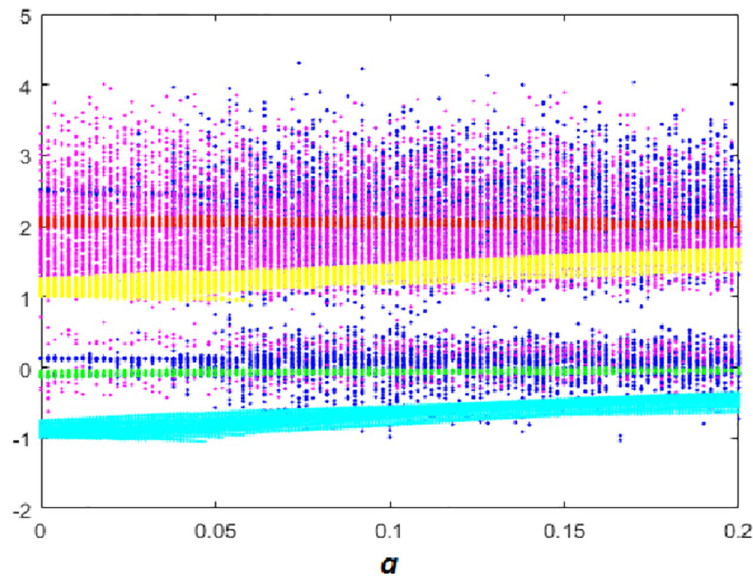
Fig 11. Bifurcation diagram of system (1) versus a starting from: ξ 1 (blue), ξ 2 (red), ξ 3 (green), ξ 4 (magenta), ξ 5 (yellow) and ξ 6